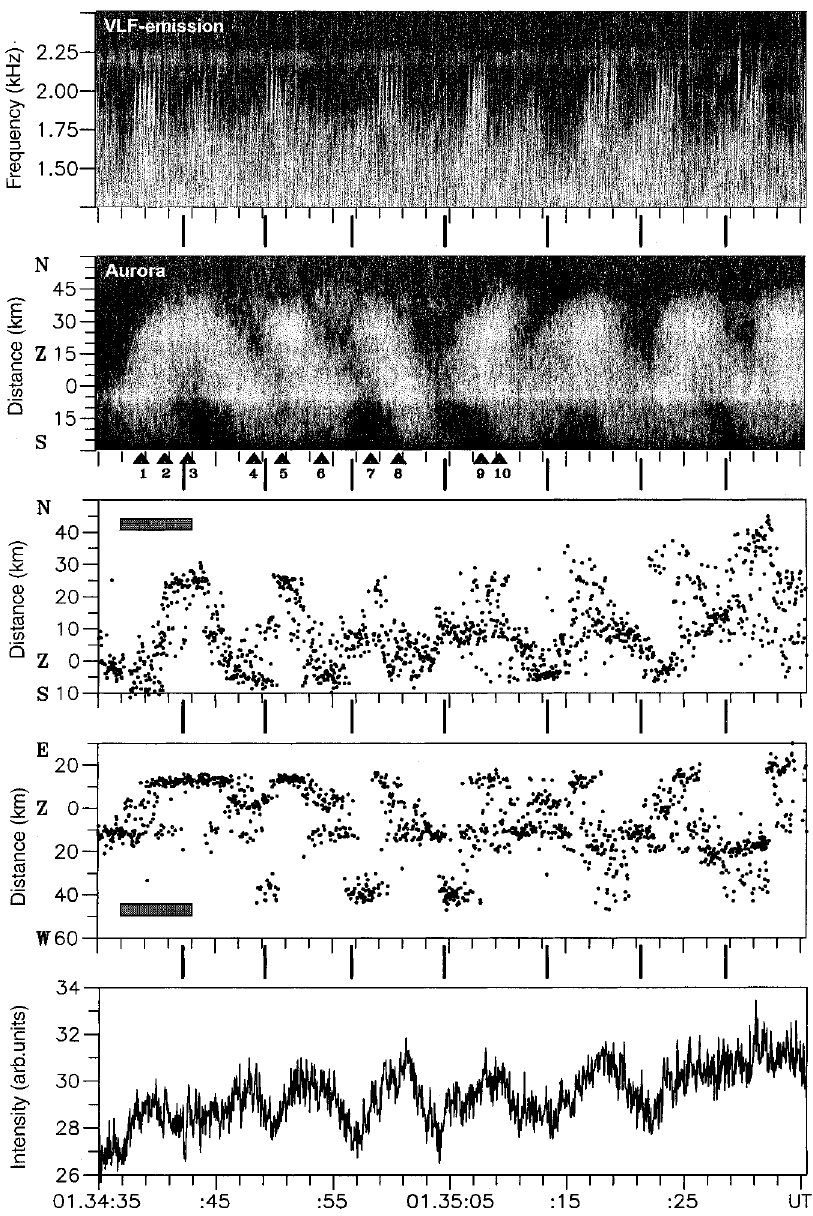
Fig. 4. The results of computer analysis of simultaneous ELF-VLF emission and auroral pulsation data. The uppermost panel shows the dynamic spectrum of the low-frequency emis- sions. The second panel shows the keogram of auroral pulsations along the direction marked by the lines in the first square in Fig. 5. The consequent locations of luminosity maxima for each TV frame in N-S and E-W directions are shown in the third panel and the fourth panels , correspondingly. Z means zenith in panels 2 to 4 . Fifth panel presents the variations of